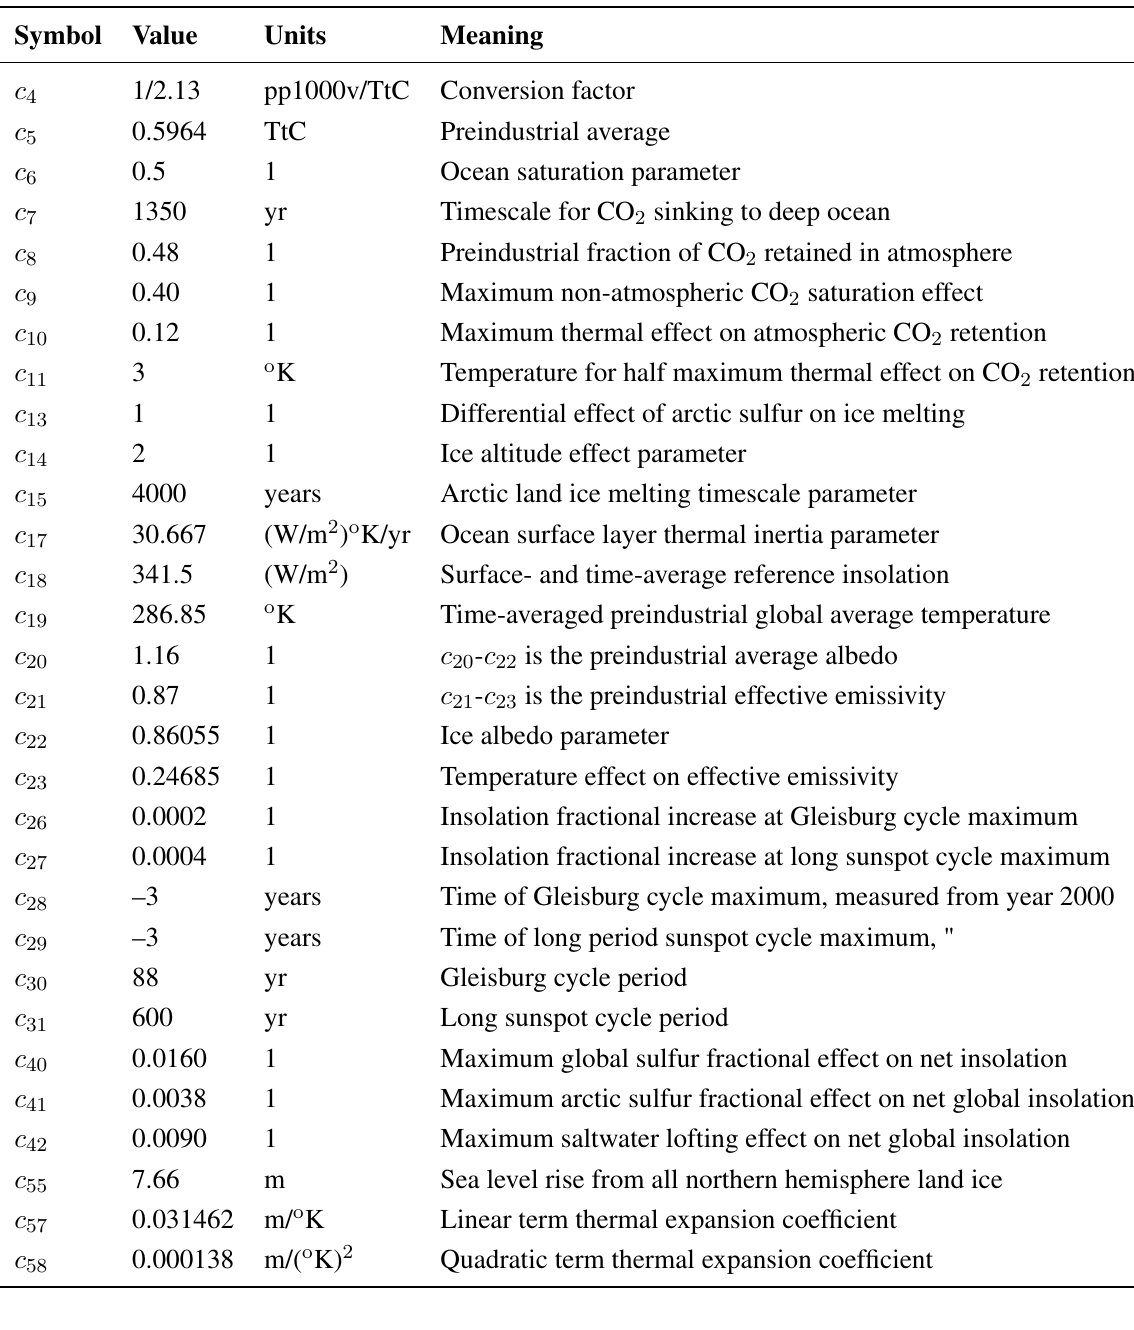
Table 3. Physical